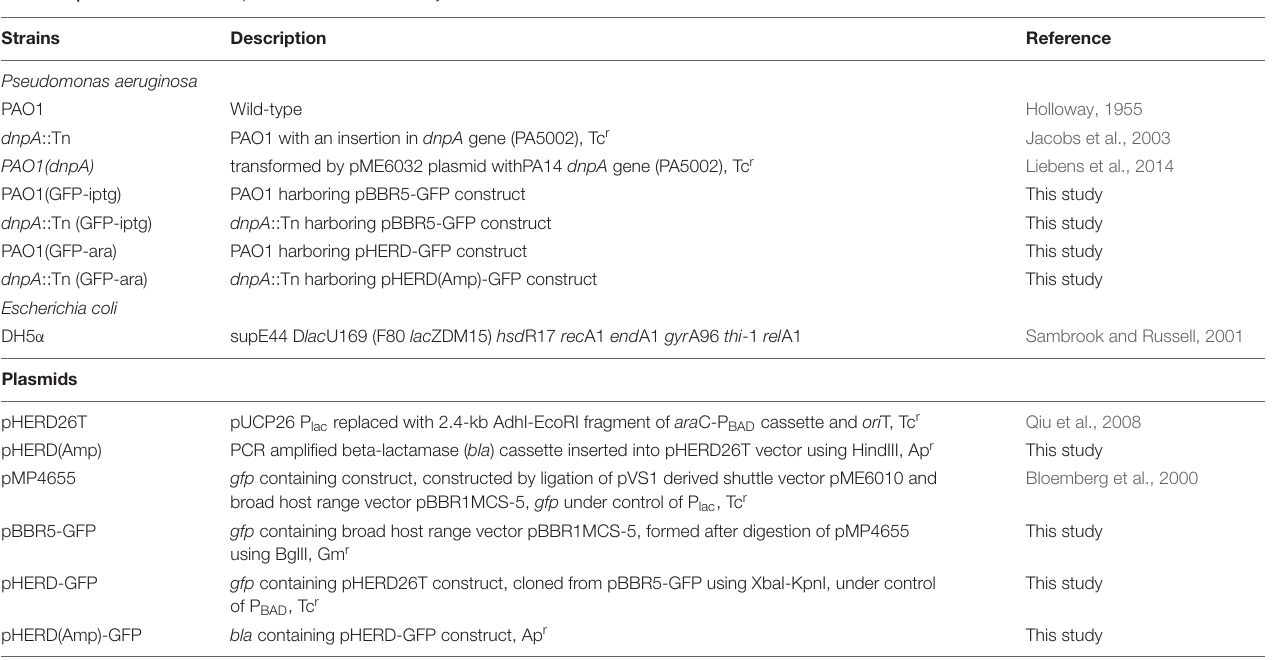
TABLE 1 | Bacterial strains and plasmids used in the